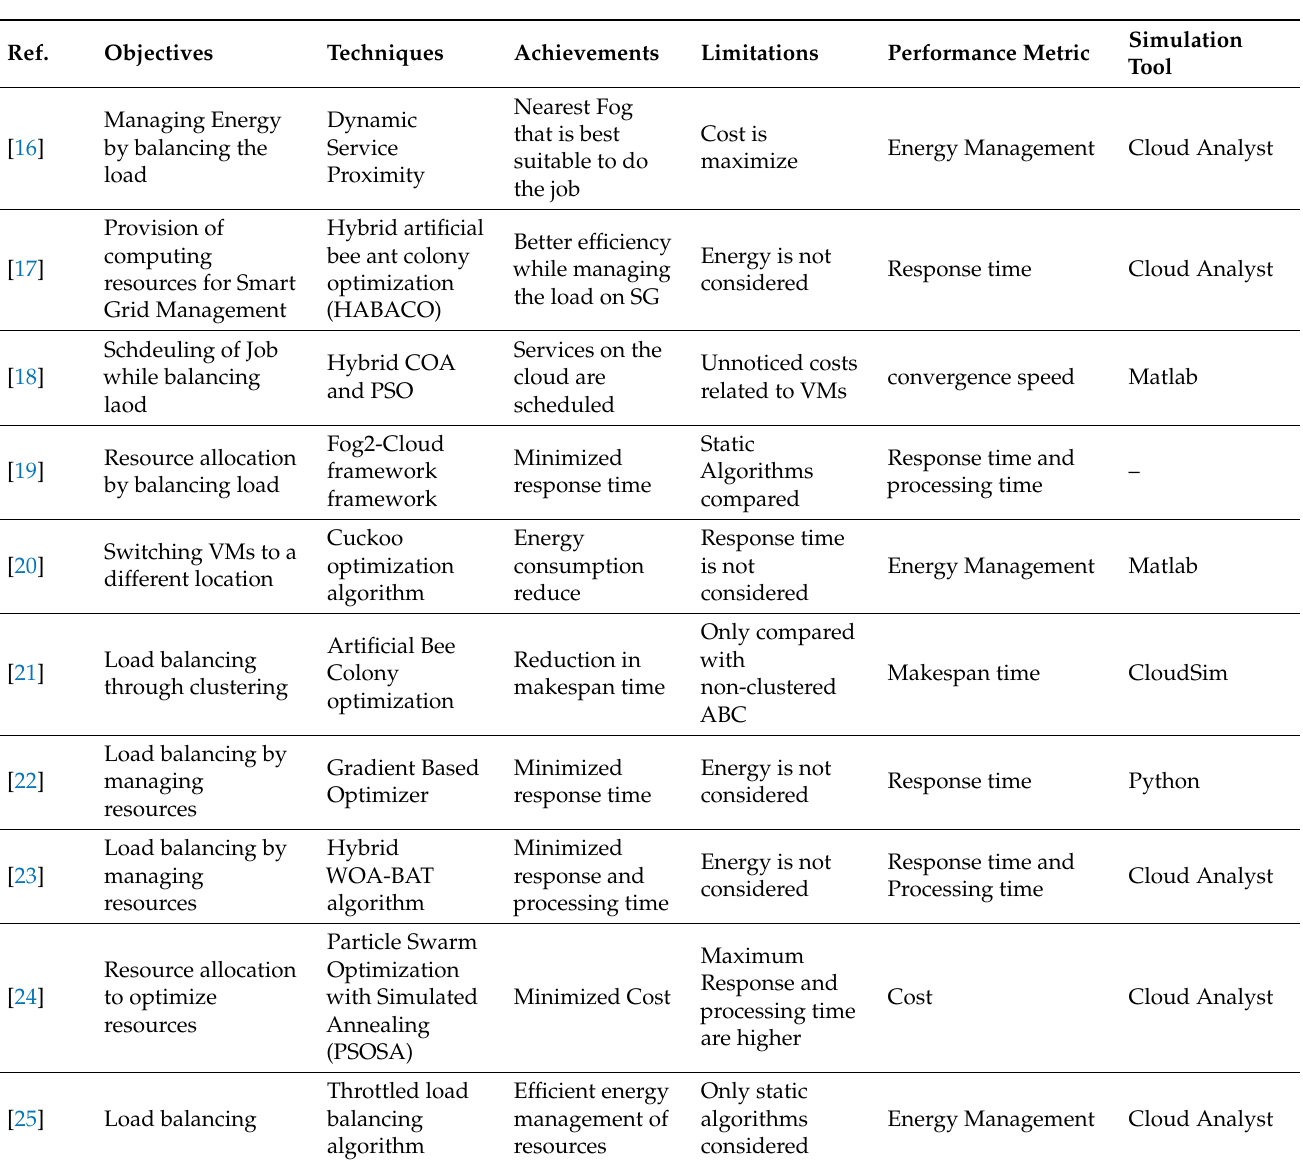
Table 2. Summary of Related